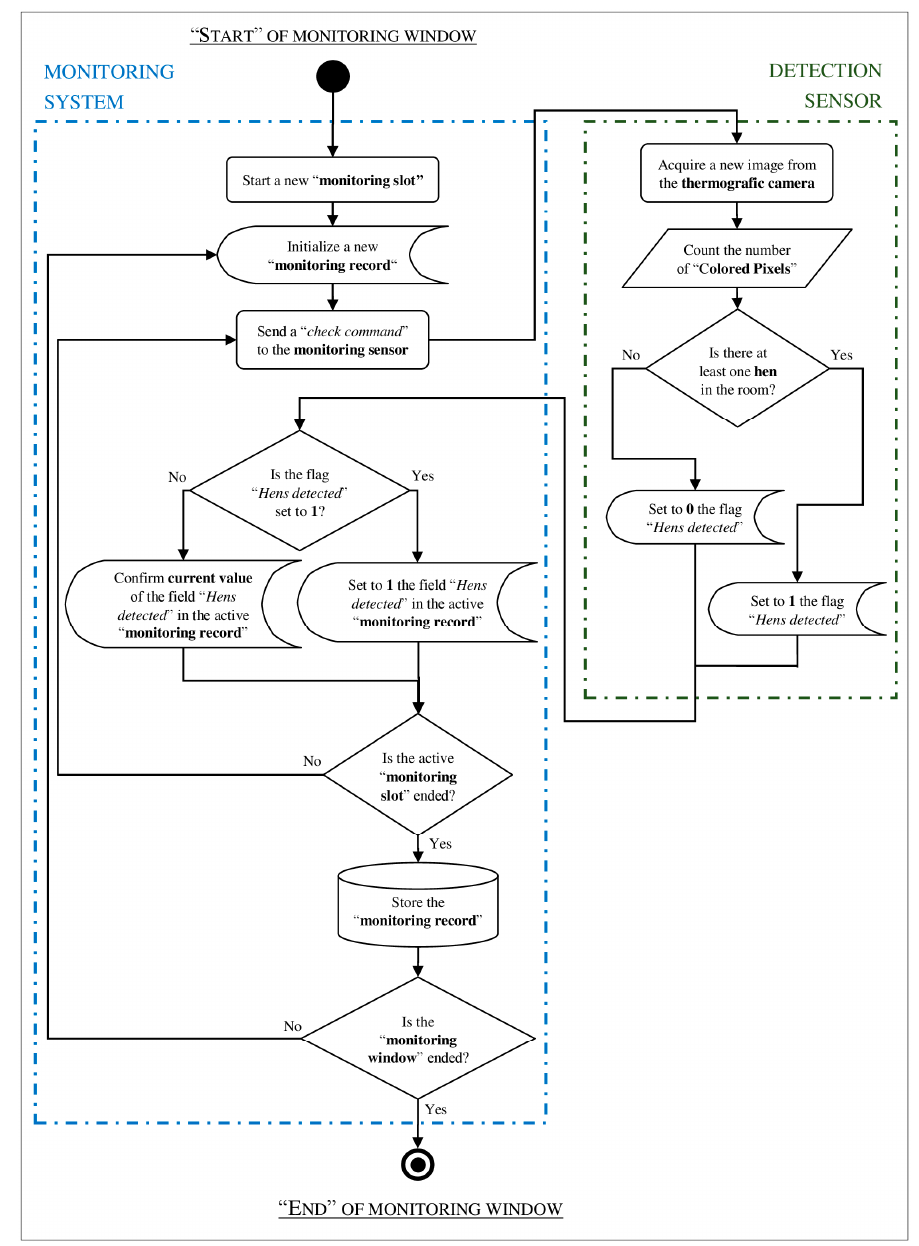
Figure 2. Flow diagram of the software applications of the monitoring system and detection sensor.